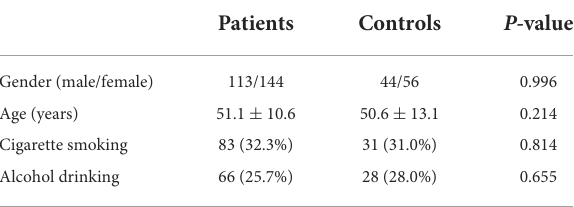
TABLE 1 Differences in baseline characteristics between healthy controls and patients with aneurysmal subarachnoid